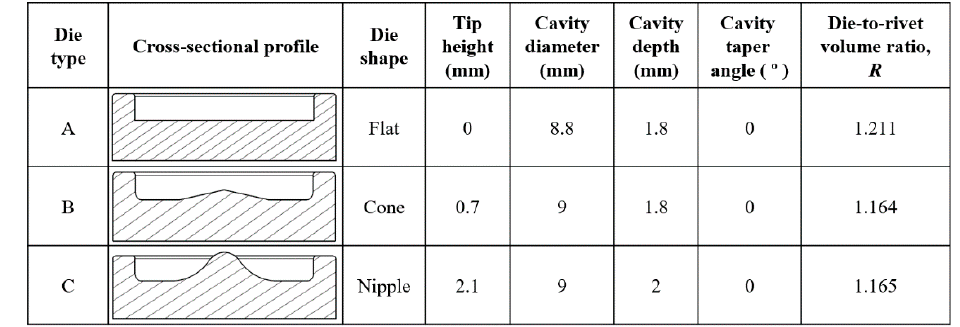
Figure 2. Geometric dimensions of the rivet used in this study. Appl. Sci. 2020 , 10 , x FOR PEER REVIEW